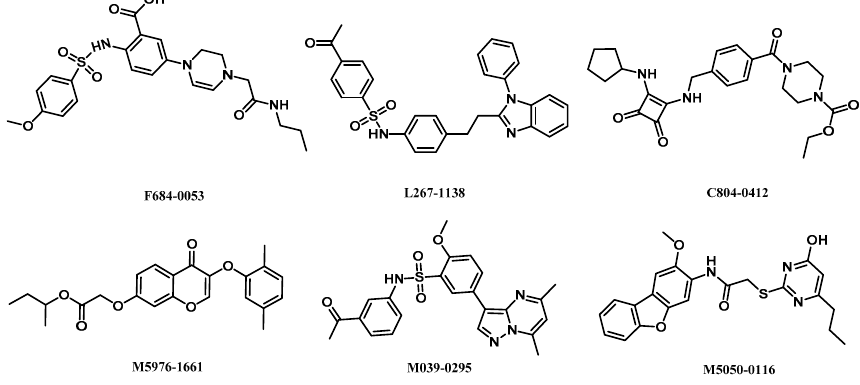
Figure 7. Structures of retrieved hits targeting α 2 β 1 γ 1 AMPK isoform from ChemDiv database.